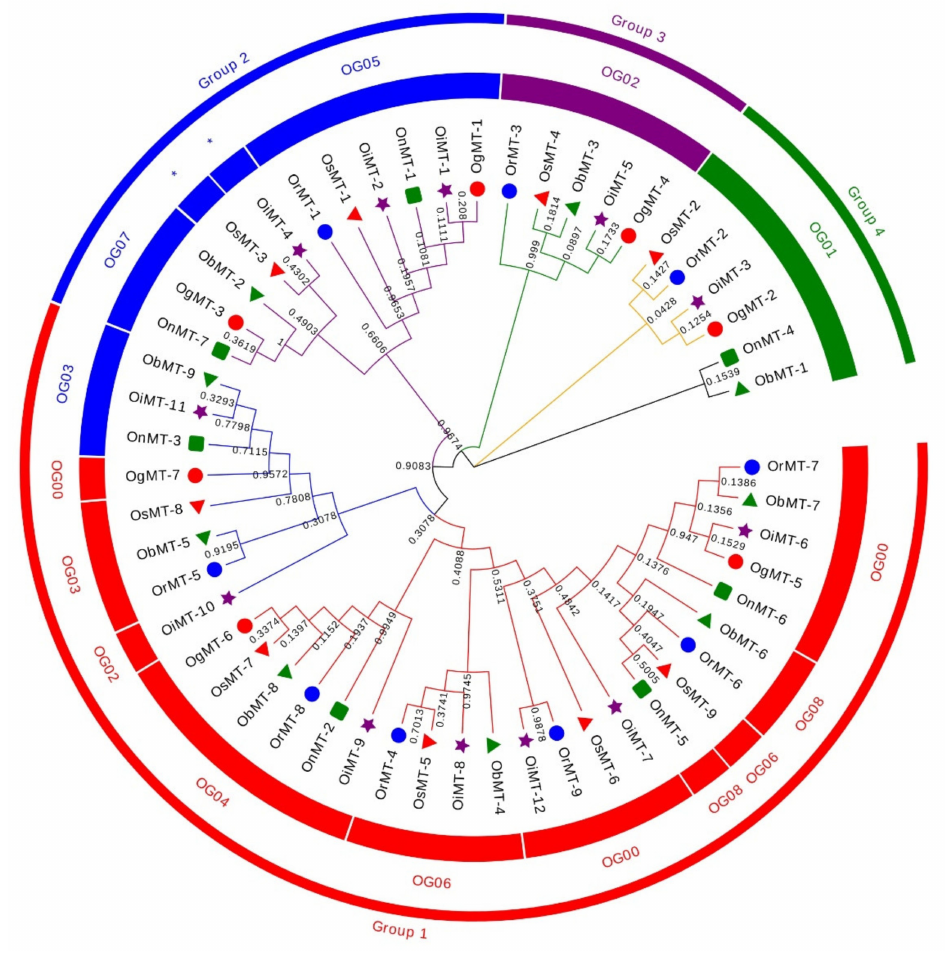
Figure 1. Phylogenetic tree of MT genes based on protein sequences from six Oryza species/subspecies. ClustalW is used for multiple sequence alignment. MEGA v.7.0 is adopted for phylogenetic reconstruction using the neighbor-joining (NJ) clustering method. Bootstrap numbers (1000 replicates) are shown. Different color of circles represents different subfamilies. Different- shaped markers indicate the different species. The numbers inside the red circles represent the different orthogroups (OGs). * means unassigned